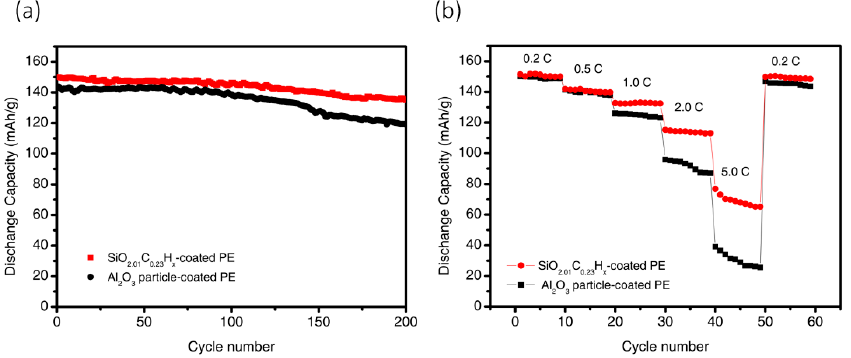
Figure 6. ( a ) The cycling performance; ( b ) C-rate capacity.